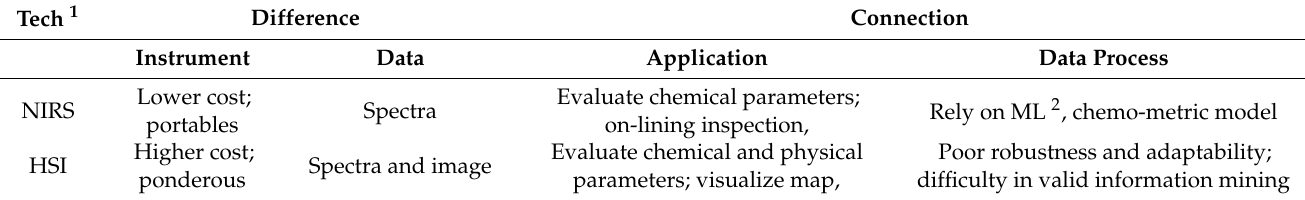
Table 1. Summary of the difference and connection between the NIRS and HSI systems.